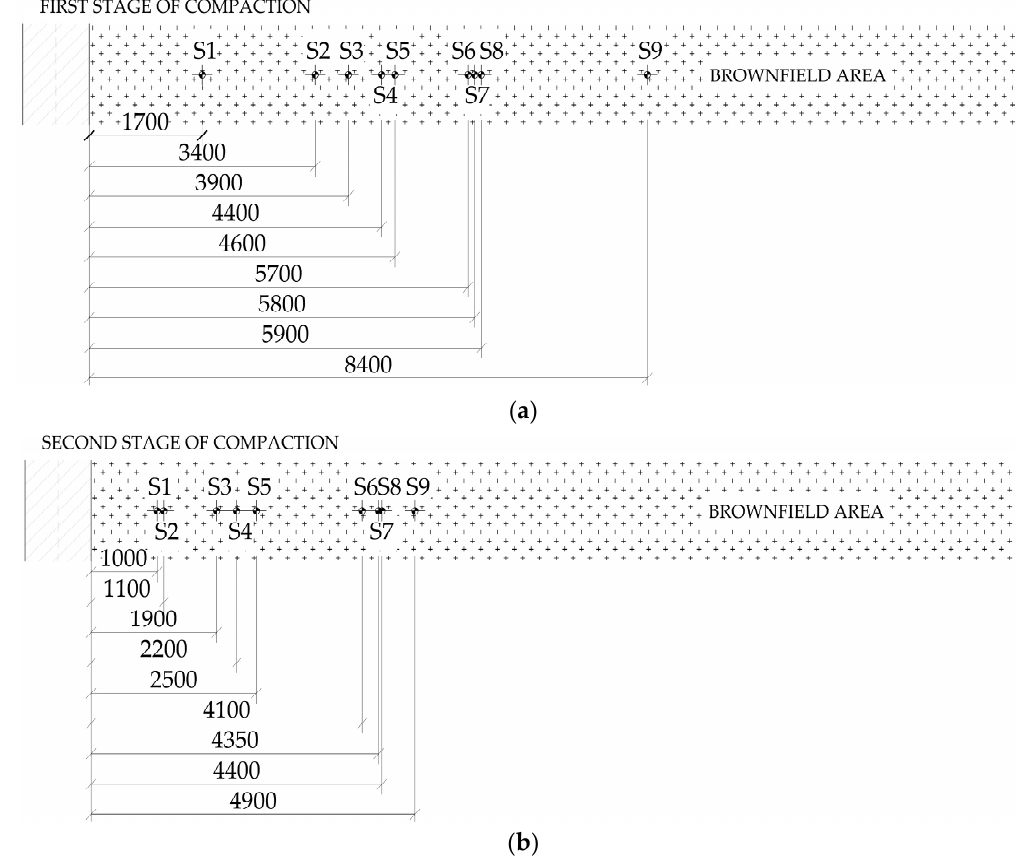
Figure 10. Measurement situation—vibrating rollers: ( a ) first and ( b ) second stages of compaction.